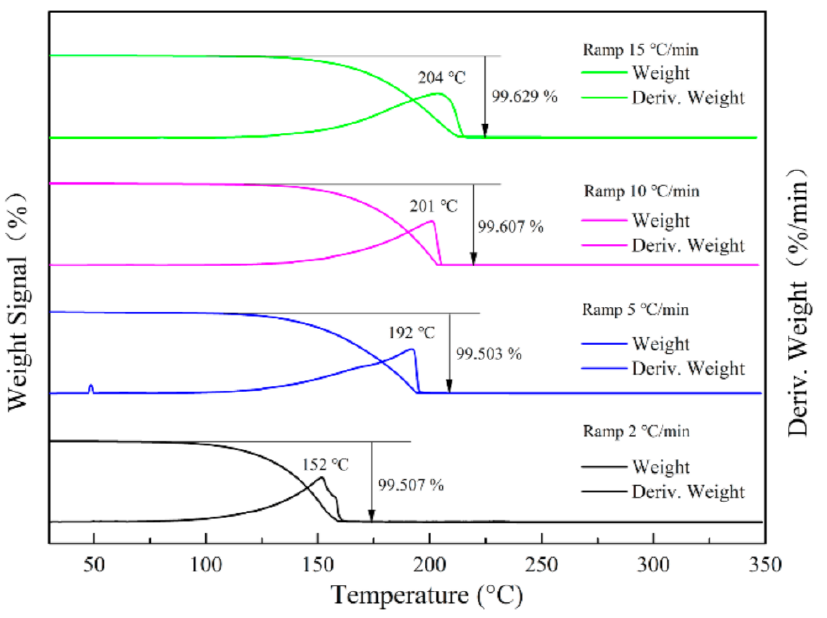
Figure 4. TG curves for DFTANA at different heating rates of 2, 5, 10 and 15 ◦ C min − 1 .